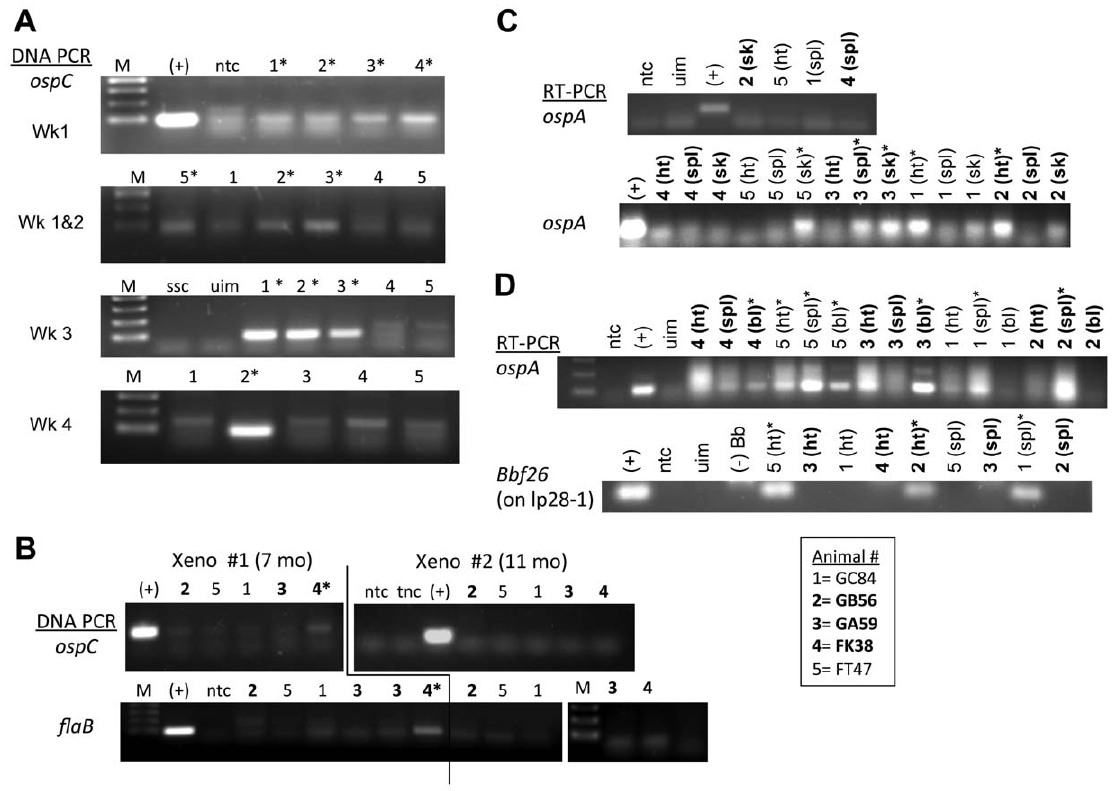
Figure 6. Nucleic acid detection of B.burgdorferi (Experiment 2). Detection by PCR or RT-PCR using primers for the indicated genes from: A) skin biopsy samples; B) xenodiagnostic ticks; C) organ tissue culture pellets; and D) directly from tissues known to harbor the spirochetes. Animal numbers in bold are of those that were treated. Asterisks indicate clear positive amplimers.sk=skin; h t=heart; bl=bladder; spl=pleen. Labels include: M=marker (100 bp ladder); ( + )= B.burgdorferi , strain B31 DNA/RNA; ssc=spirochete strain negative control ( Bb strain JD1 DNA); ntc=no template control; tnc=tick negative control; uim=uninfected monkey DNA/RNA.